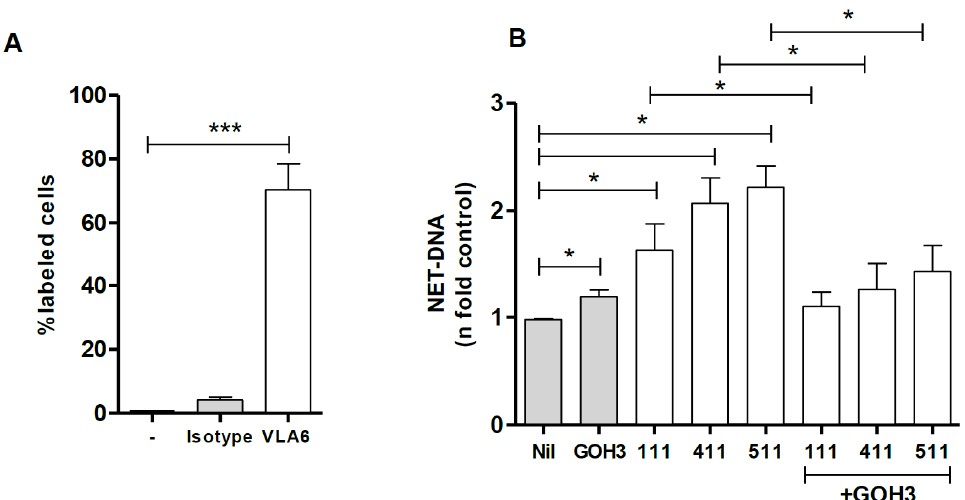
Figure 2. Neutrophils express the α 6 integrin chain (CD49f/VLA-6), and NETs are released as a result of recognition of LM isoforms by this integrin. Neutrophils were incubated with anti- α 6 chain antibody (GOH3) or the isotype control (2 µg/mL) for 20 min at 4 °C, and CD49f expression was evaluated. The data are shown as the mean ± SEM of the percentage of CD49f+ neutrophils ( A ) in samples from six different donors. Neutrophils were either untreated (Nil) or treated with anti- α 6 integrin antibody (GoH3) for 20 min and then incubated with LMs 111, 411, and 511 for 60 min. NETs in culture supernatants were quantified using PicoGreen ( B ). The data were normalized according to spontaneous release of DNA (Nil) from unstimulated neutrophils and are presented as the mean ± SEM of 7 (LM-111), 10 (LM-411) and 8 (LM-511) donors. *** p < 0.001; * p < 0.05.